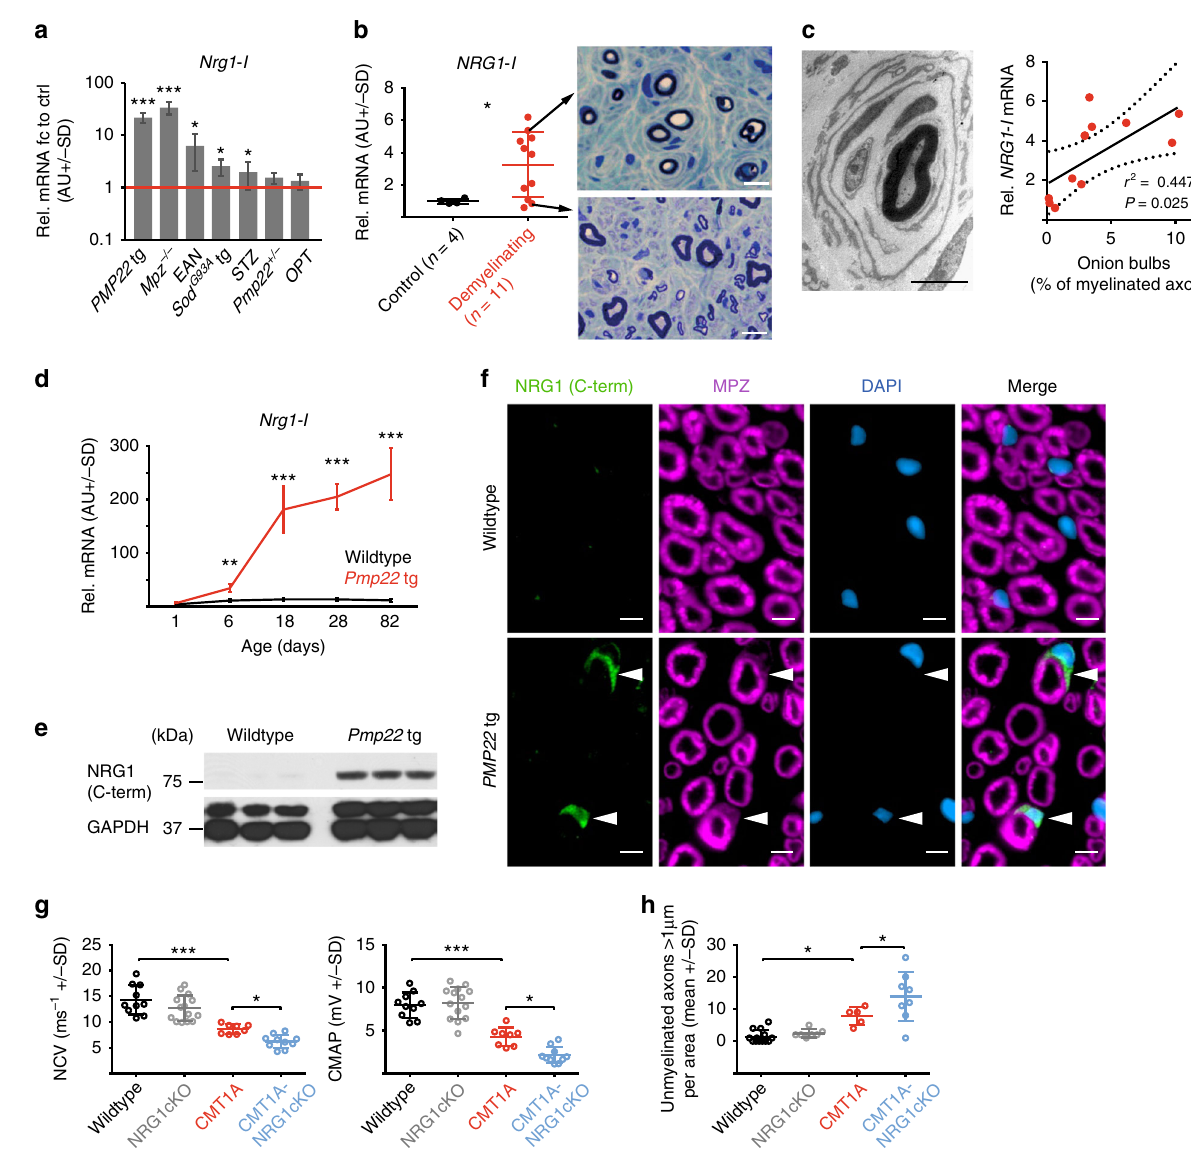
Fig. 1 Neuregulin-1 type 1 (NRG1-I) expression by Schwann cells in various demyelinating neuropathies. a Nrg1-I mRNA expression in sciatic nerves of different rodent models for peripheral neuropathies. Nrg1-I mRNA induction is most pronounced in demyelinating models ( PMP22 tg mice, CMT1A model; Mpz − / − mice, model for congenital hypomyelination; EAN rats, experimental autoimmune neuritis) compared to predominant axonal neuropathies ( SOD G93A tg mice, model for amyotrophic lateral sclerosis; Streptozotocin (STZ)-treated mice, diabetic neuropathy model; Pmp22 + / − mice, model for hereditary neuropathy with liability to pressure palsies; Oxaliplatin (OPT)-treated rats, toxic neuropathy model). Sciatic nerves were collected from adult (age 3 – 4 months) experimental rodents and age-matched controls, respectively ( n = 5 per group). Shown is Nrg1-I mRNA expression relative to control level ( = 1, red line). (Student ’ s T test). b NRG1-I mRNA expression (standardized to Schwann cell marker S100 ) is increased in sural nerve biopsies with a demyelinating histopathology ( n = 11) compared to controls ( n = 4, Student ’ s T test, left panel). Semithin cross-sections of representative human sural nerve biopsies with high and low NRG1-I expression are shown in right panels (scale bar 10 µ m). c Pearson correlation analysis (right panel) of sural nerve NRG1-I mRNA expression and onion bulb frequency reveals a signi fi cant positive correlation between NRG1-I expression and the number of onion bulbs (data from b ). An electron micrograph exemplarily depicts an onion bulb (scale bar 5 µ m). d In CMT1A rats, Nrg1-I mRNA expression in sciatic nerves increases with age and disease progression ( n = 4 – 5 per group, multiple T tests). e Western blot analysis of NRG1 protein (C-terminal antibody) in sciatic nerve lysates of 3-month-old CMT1A rats compared to wild-type animals ( n = 3 per group, GAPDH as loading control; for full blots, see Supplementary Figure 5). f Immunohistochemistry on sciatic nerve cross-sections from 3-month-old wild-type (upper panels) and CMT1A mice (lower panels) showing NRG1 expression (green, C terminal SC348 antibody) only in Schwann cells of CMT1A mice. Myelin was stained with MPZ (magenta) and nuclei were with DAPI (blue) (scale bar 2.5 µ m). g Quanti fi cation of nerve conduction velocity (NCV, left panel) and compound muscle action potential (CMAP) amplitudes (right panel) in P18 mice (wild type n = 10, NRG1cKO n = 14, CMT1A n = 8, CMT1A-NRG1cKO n = 10, one-way analysis of variance (ANOVA) and Tukey ’ s post test). h Quanti fi cation of the number of unmyelinated axons (>1 µ m) per area (15,740 µ m 2 ) on electron microscopic level of P18 mice (wild type n = 12, NRG1cKO n = 7, CMT1A n = 5, CMT1A-NRG1cKO n = 8, one-way ANOVA and Tukey ’ s post test). Source data are provided as a source data fi le. All respective p values are depicted as a range of signi fi cance with * p < 0.05; ** p < 0.01; and *** p <